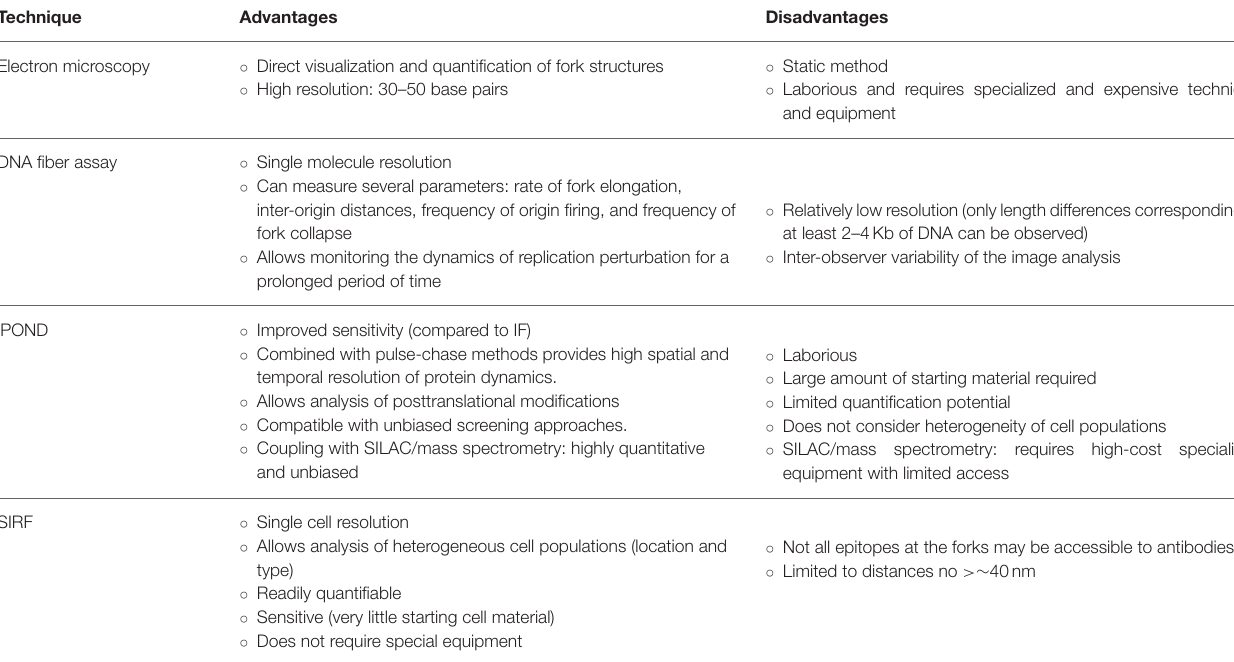
TABLE 1 | Summary of the advantages and disadvantages of the different techniques used to study replication fork biology. Technique Advantages